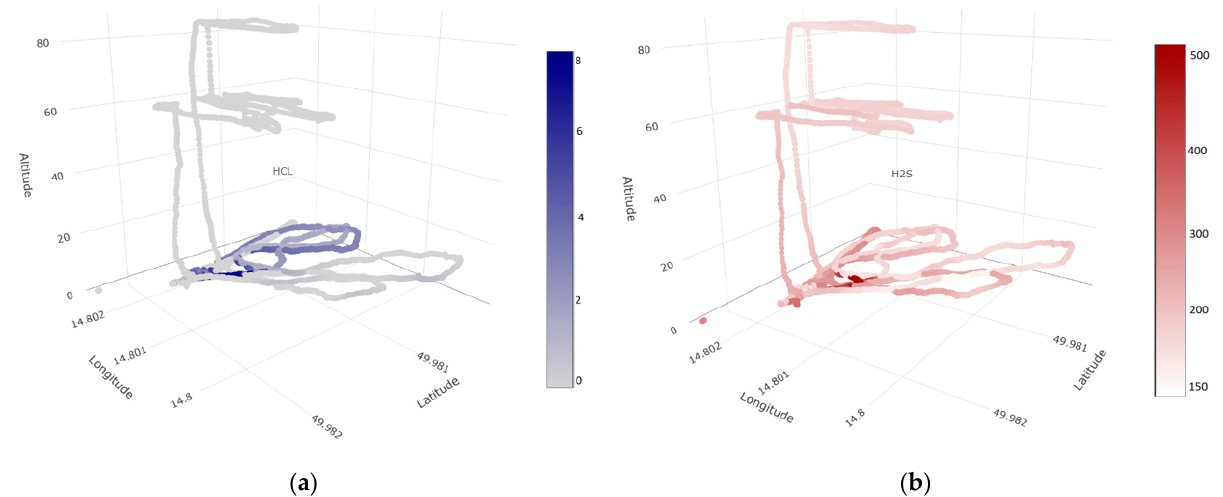
Figure 7. 3D models present the most sensitive sensors during data collection: ( a ) HCL sensor and ( b ) H 2 S sensor measured by electronic nose.